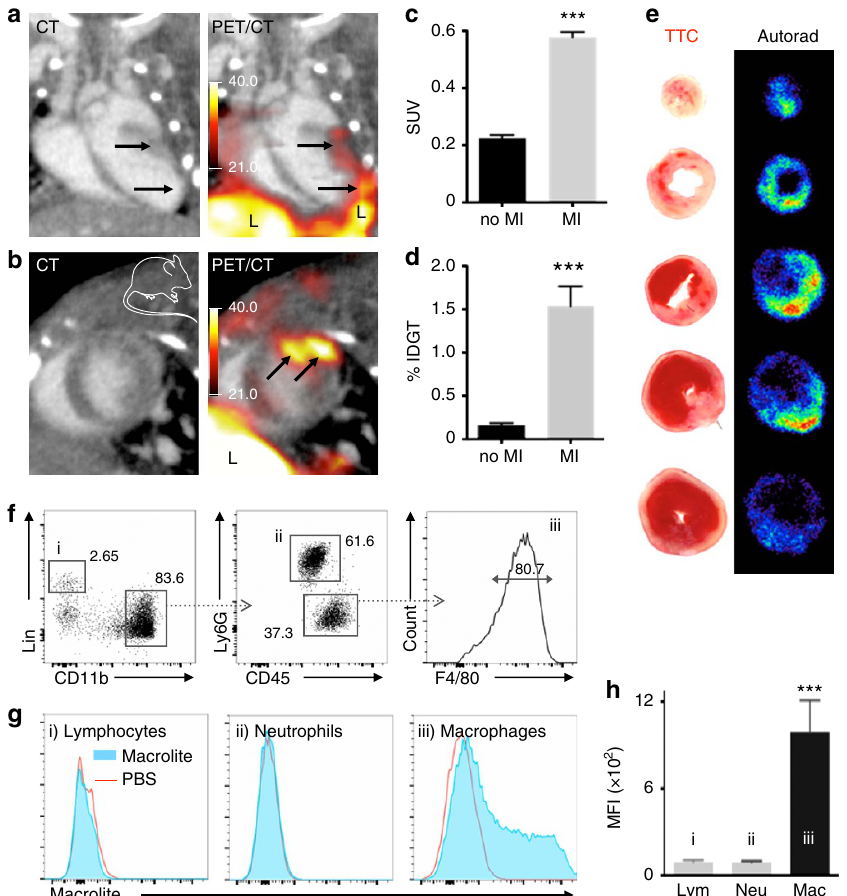
Figure 5 | Macrophage PET imaging in murine myocardial infarction (MI). Macroflor enriches in macrophages residing in acute infarcts. ( a ) PET-CT long axis and ( b ) short axis views following IV Macroflor injection into C57BL/6 mice on day 6 after MI. PETscale bar is in kBq/cc. ( c ) In vivo SUVquantification of Macroflor signal in non-infarcted and infarcted heart tissue ( n ¼ 4 per group, unpaired t-test). ( d ) Ex vivo gamma counting data of MI tissue (%IDGT (percent injected dose per gram tissue), n ¼ 4–5, unpaired t -test). ( e ) Ex vivo autoradiography signal corresponds with pale triphenyltetrazolium staining of day 2 infarct on short axis sections. Representative images from experiments obtained in four mice with infarcts. ( f ) Flow cytometric gating on infarct leukocytes after IV Macrolite injection. ( g ) Histograms of Macrolite uptake into respective cell populations. ( h ) Mean fluorescence intensity (MFI) reflecting Macrolite uptake, obtained in three mouse infarcts (one-way analysis of variance test). Data are shown as mean ± s.e.m., * indicates P o 0.05, *** indicates P o 0.0001. Mouse cartoon image is reproduced from the servier medical art image data bank (http://www.servier.com/Powerpoint-image-